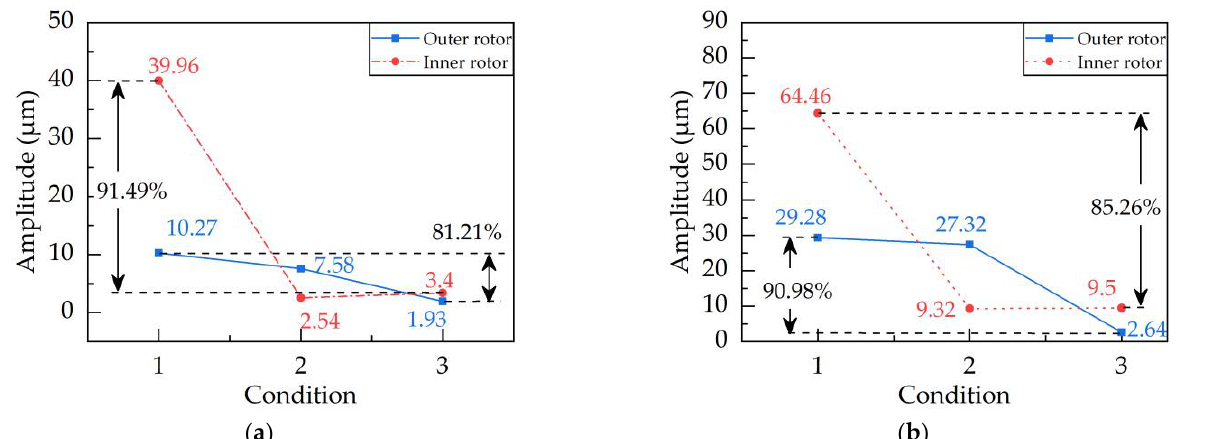
Figure 13. Coupled vibration suppression effect under differential speed. ( a ) n = − 1.5; ( b ) n = − 1.2. The horizontal coordinate 1 represents the initial state, the horizontal coordinate 2 represents the dynamic balance of the inner rotor, and 3 represents the dynamic balance of the outer rotor.